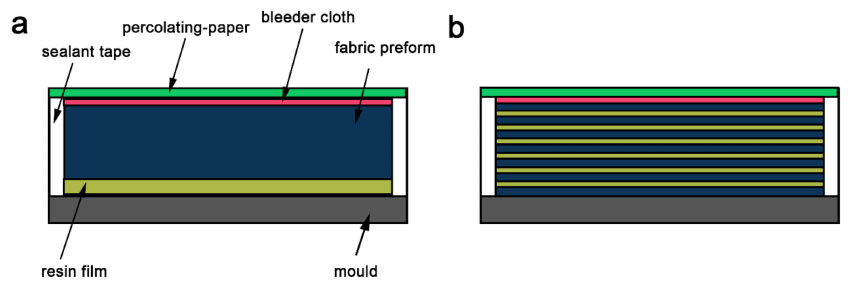
Figure 1. Schematic illustration of the preform fabrication process using percolating-assisted resin film infusion method: ( a ) Coating preparation, ( b ) embedded interlayer